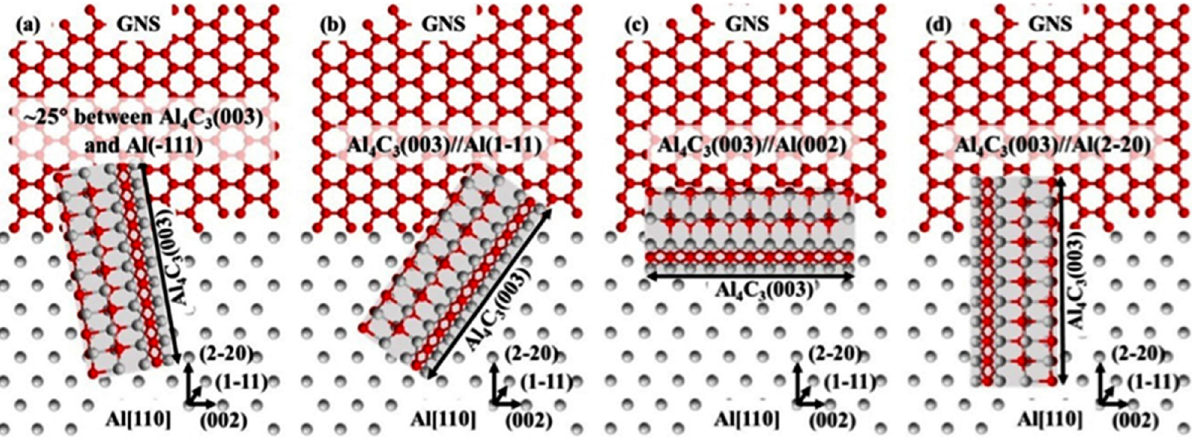
Figure 3: The nucleation and the growth mechanisms of Al 4 C 3 where ( a ) ∼ 25° angle between Al 4 C 3 ( 0003 ) and Al (- 111 ) ; ( b ) Al 4 C 3 ( 0003 ) //Al ( 1 - 11 ) ; ( c ) Al ( 0003 ) //Al ( 002 ) , and ( d ) Al ( 003 ) //Al ( 2 - 20 ) . Reproduced from ref. [ 39 ] 4 C 3 4 C 3